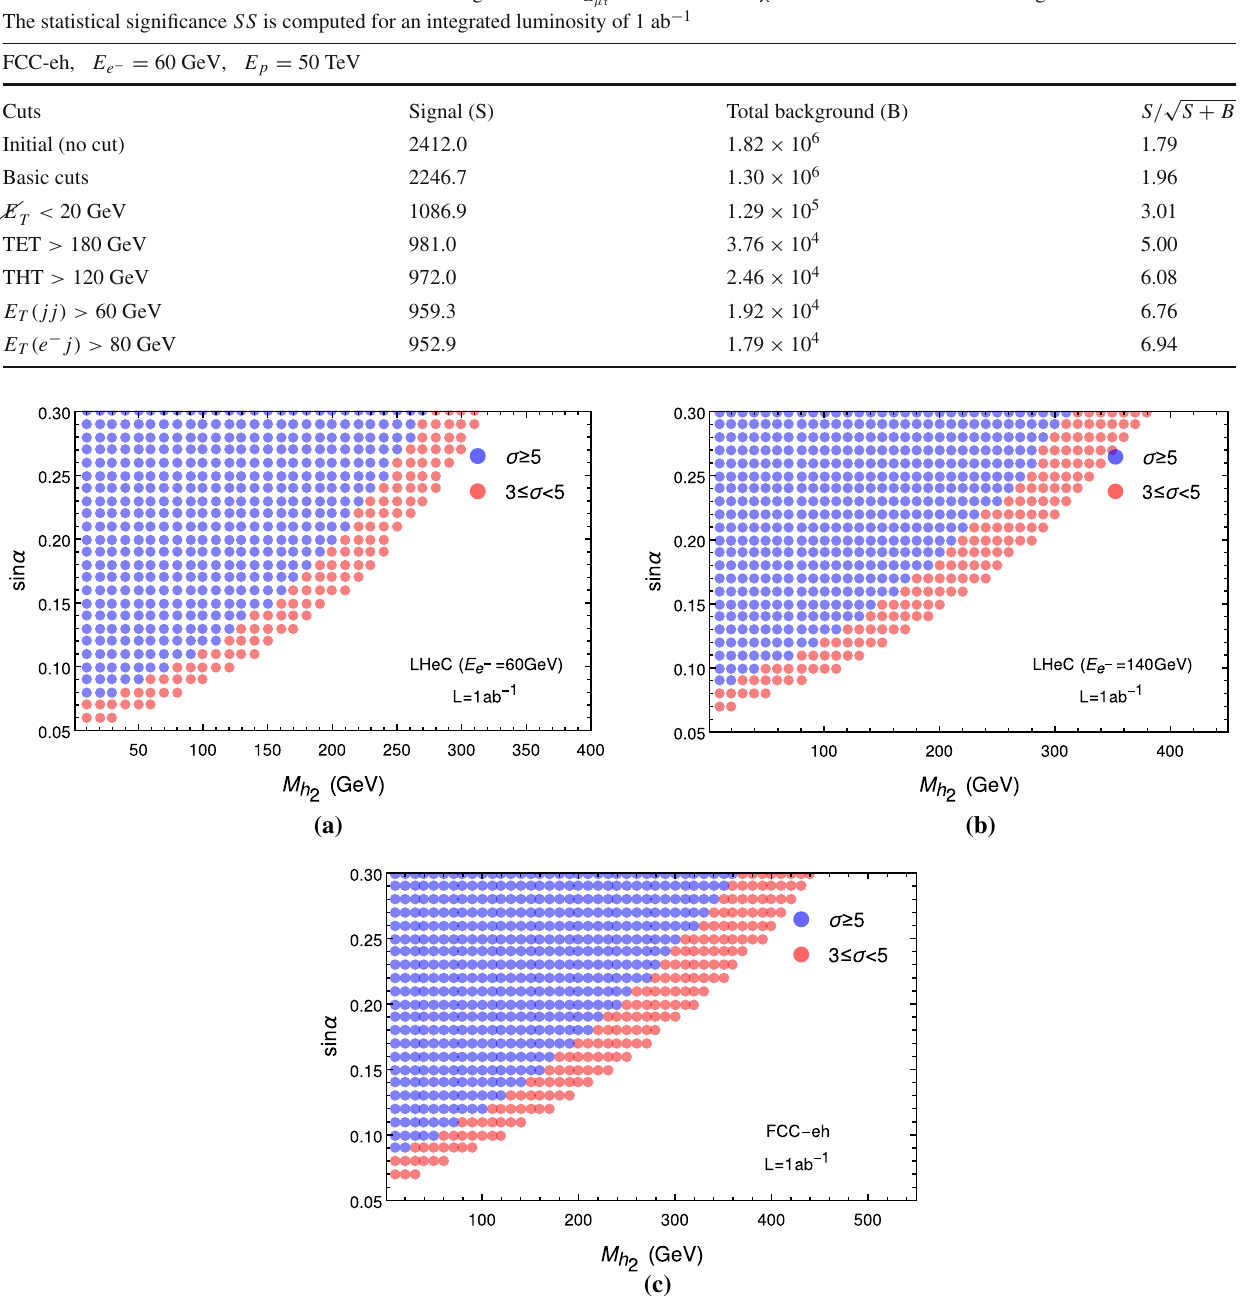
= 0 . 1 GeV and χ = 9 × 10 − 5 GeV − 1 and backgrounds at the FCC-eh. μτ